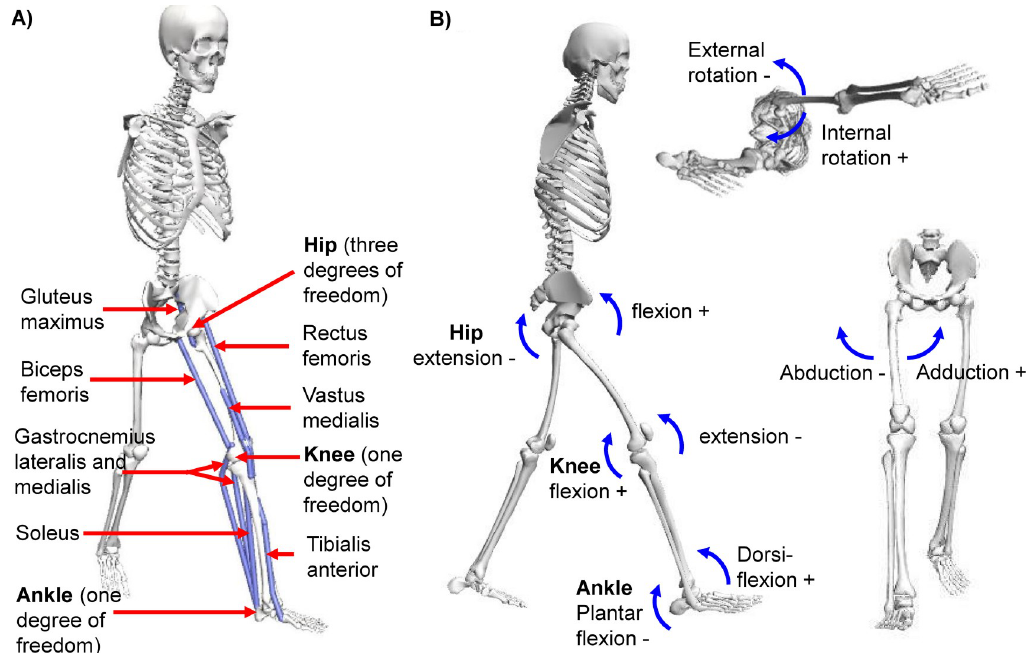
Fig 3. Models for musculoskeletal and joint-space methods. Kinematic, kinetic, and musculoskeletal analyses were performed in OpenSim using a model based on Rajagopal et al., [48]. (a) Musculoskeletal method. Schematic of the model that was used to estimate muscle-tendon paths and calculate the muscle metabolic rate, and the degrees of freedom that were used for each joint. The muscles shown were simulated based on EMG recordings. (b) Joint-space method. Schematic of the joints that were used to estimate the metabolic rate time profile using the method from Roberts et al., [23] and the sign conventions for joint angular velocity and joint